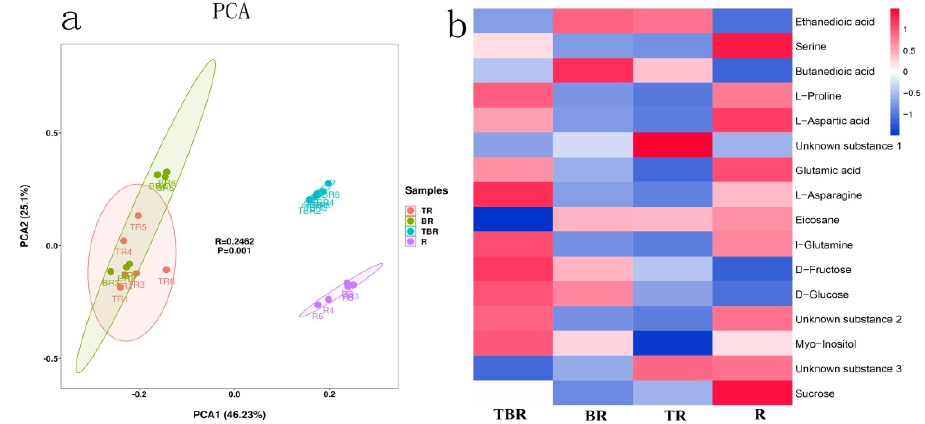
Figure 3. Graphical representation of changes in the metabolite profiles. ( a ) Principal component analyses (PCA) applied to tomato plants of different treatments according to their entire primary metabolome set of 16 metabolites; ( b ) heat-map of these 16 primary metabolites in different treatments. The treatments were as follows: R = Ralstonia solanacearum (RS-15) (as control); TR = Trichoderma virens (Tvien6) + RS-15; BR = Bacillus velezensis (X5) + RS-15; and TBR = Tvien6 + X5 + RS-15. The values of the heatmap are shown as the mean of six replications. Note: The color from red (value 1) to blue (value − 1) represents the relative content of metabolites from high to low.